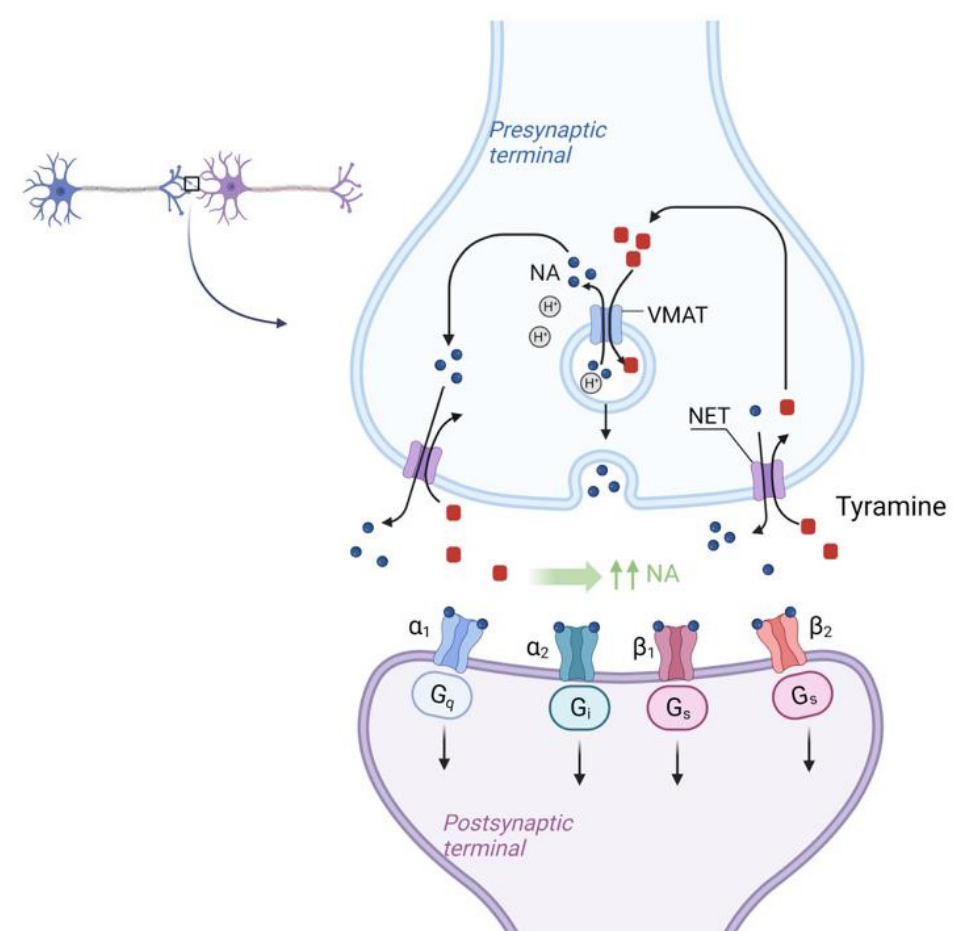
Figure 4. Molecular mechanism of NET (Norepinephrine transporter) activation by tyramine in SFP. Tyramine from the synaptic cleft is transported to the synaptic bulb by the NET (Norepinephrine transporter) in exchange for NE itself. Once inside the synaptic bulb, tyramine is transferred inside the vesicle by the vMAT (vesicular monoamine transporter), located on the membrane of these vesicles, in exchange for NE. This NE then enters the synaptic cleft again via the NET in exchange for tyramine and the cycle repeats. As a result, there is a sharp increase in the concentration of NE in the synaptic cleft. NET—norepinephrine transporter, vMAT—vesicular monoamine transporter.